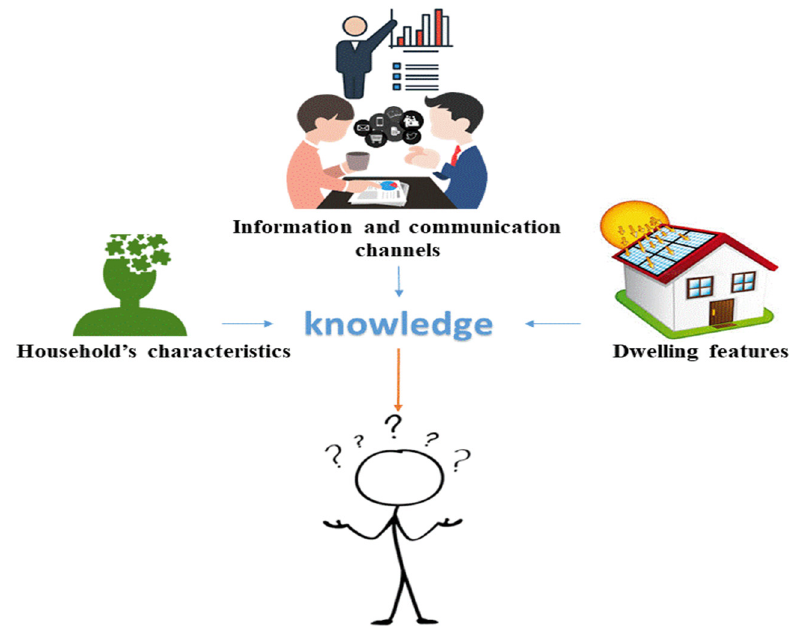
Figure 4. Influential information sources that shape individuals’ attitudes.